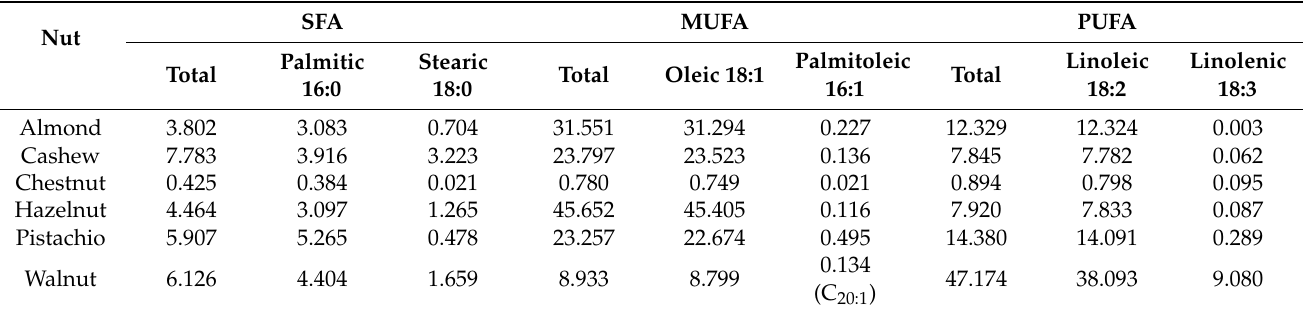
Table 5. Fatty acid composition of selected nuts (g/100 g nut) (Source: